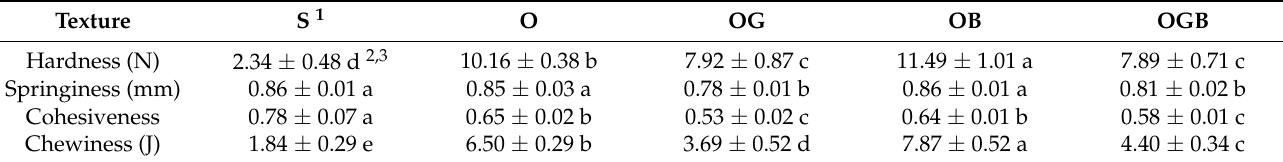
Table 3. Texture analysis results of muffins containing fortified-oleogel as a shortening replacer.